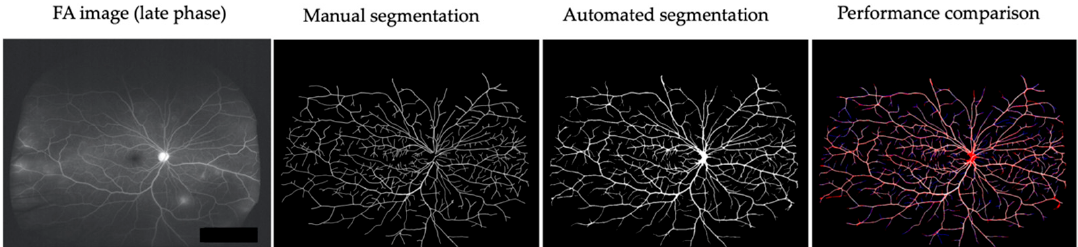
Figure 2. Comparison of manual and automated segmentation of retinal vessels in a representative case (Behçet’s uveitis). Two FA images (early-phase and late-phase UWF FA images) of six patients before treatment were used for segmentation of retinal vessels. True positive: white. False negative: blue. False positive: red.